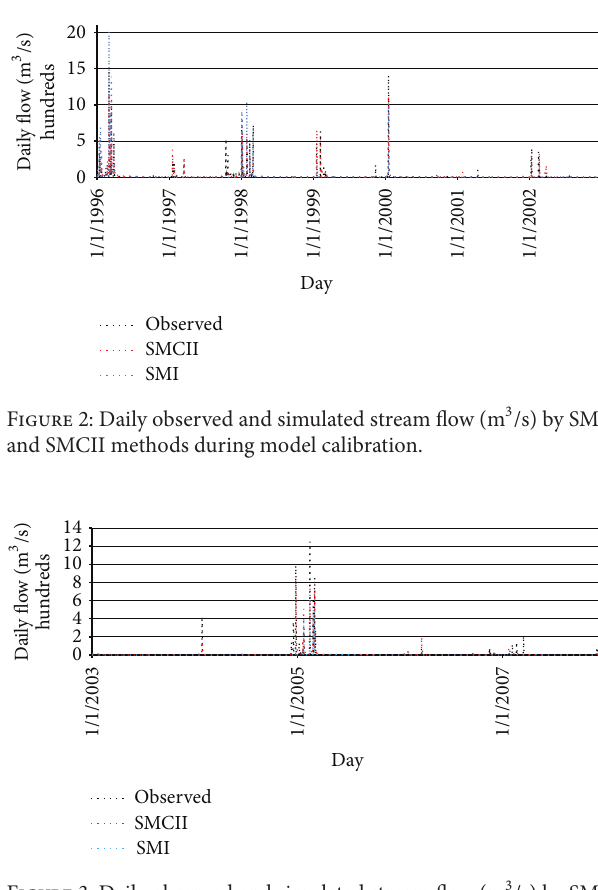
Figure 3: Daily observed and simulated stream flow (m 3 /s) by SMI and SMCII methods during model